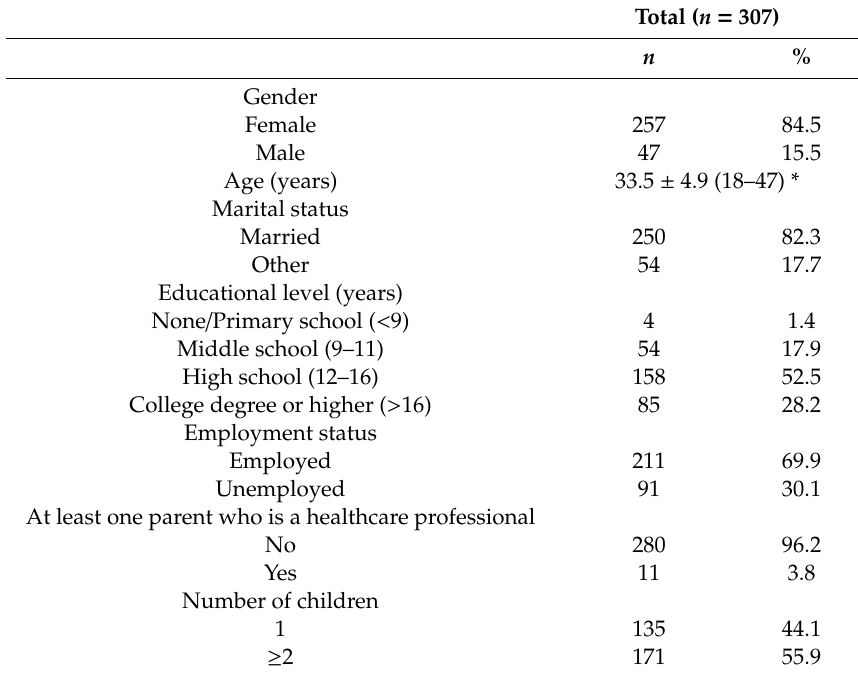
Table 1. Main characteristics of the study